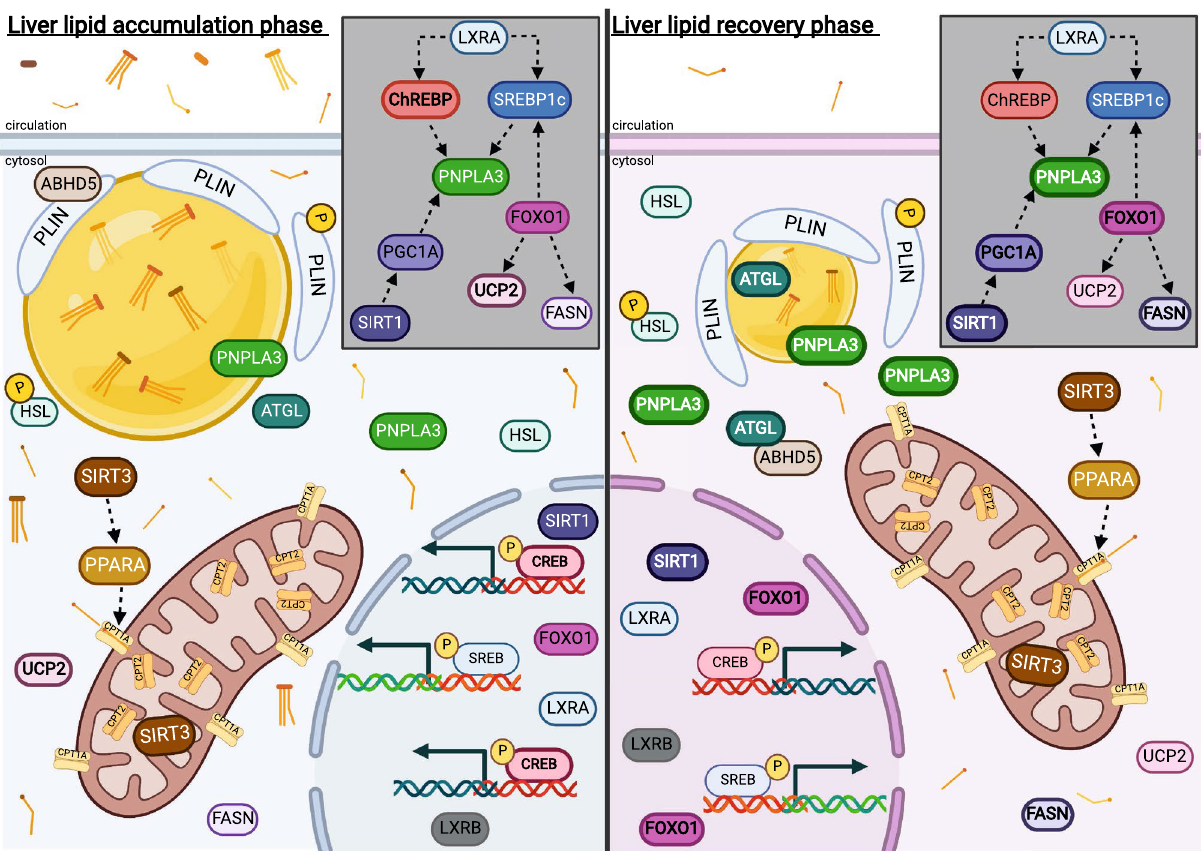
Figure 8. Working hypothesis of lipid related genes and proteins in primary bovine hepatocytes during the liver lipid accumulation phase (left panel) and the liver lipid recovery phase (right panel). The gray box insert within each panel represents the associations between PNPLA3, transcription factors, and genes where potential for regulatory influence exists. Relative abundance between panels are shown visually with line weight and quantity. Arrows between genes and proteins indicate associative relationships based on published research across species and the current data and do not denote directionality of regulation. Created with